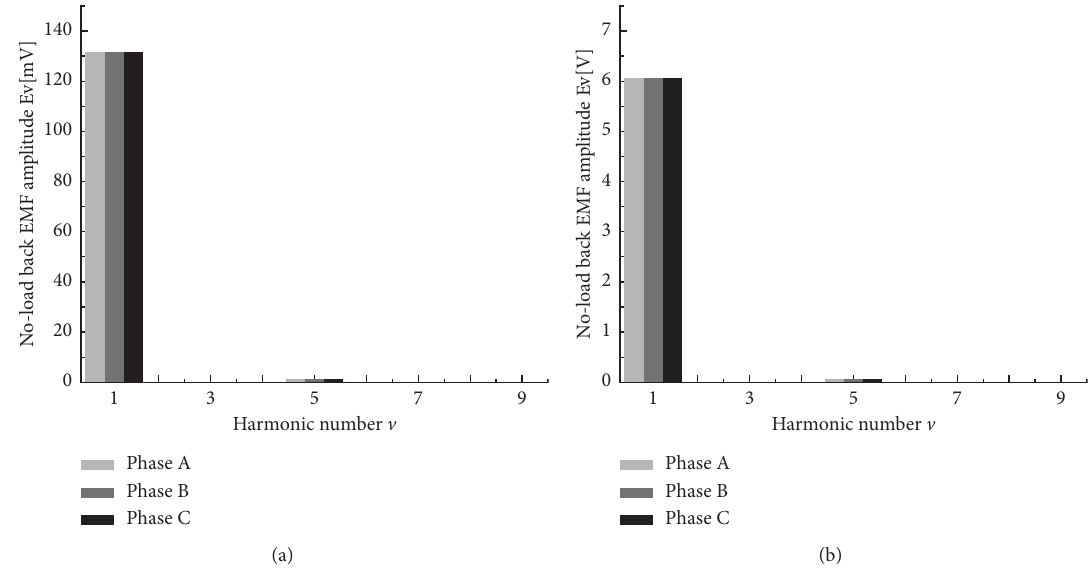
Figure 10: Harmonic analysis of no-load back EMF of the new motor at different speeds: (a) v � 0.02m/s; (b) v �